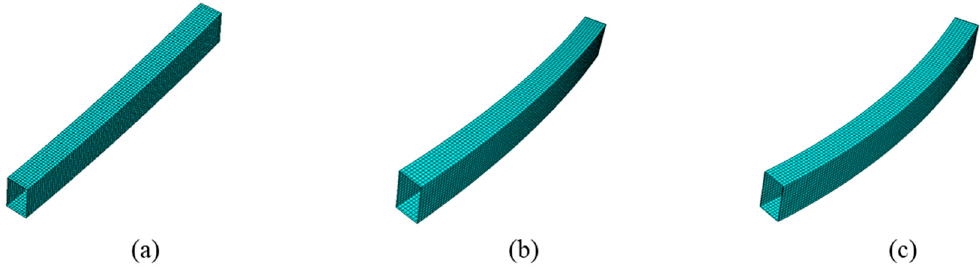
Figure 5. Finite element models in ABAQUS: ( a ) the perimeter beam on level 5; ( b ) the perimeter beam on level 15; ( c ) the perimeter beam on level 25.